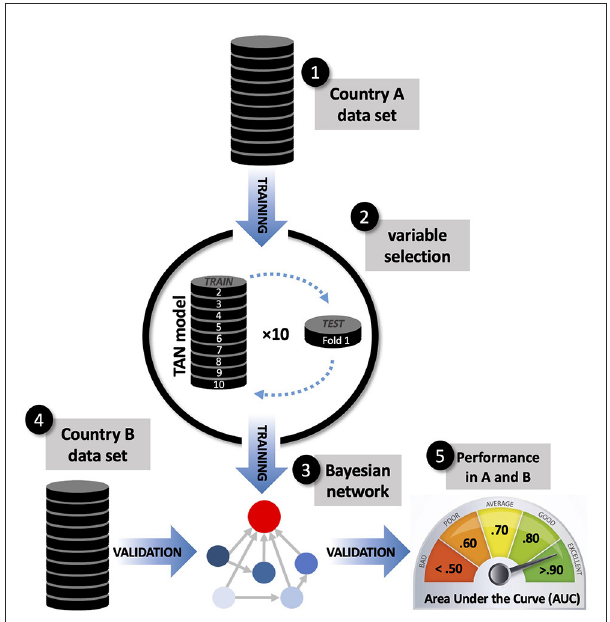
FIGURE1 Schematic representation of the cross-country, cross-validation design used to identify suicidal ideation risk factors that are country-specific and those that are common across samples. Model training used a tree-augmented naïve Bayes algorithm, applying 10-fold internal cross-validation for variable selection. Classification accuracy was assessed within-sample and out-of-sample using the Area Under the Curve